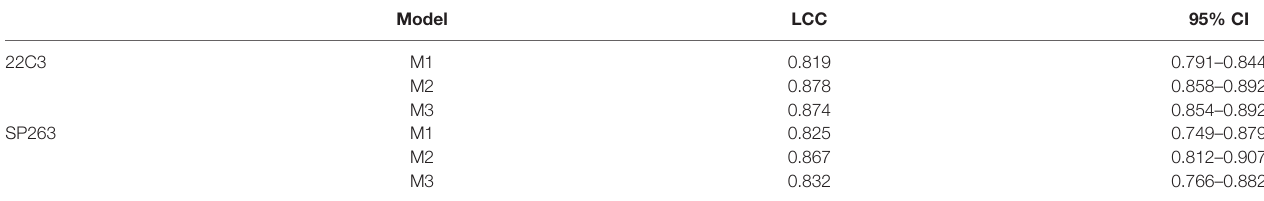
TABLE 2 | Linear correlation coef fi cient in 22C3 and SP263 assay.